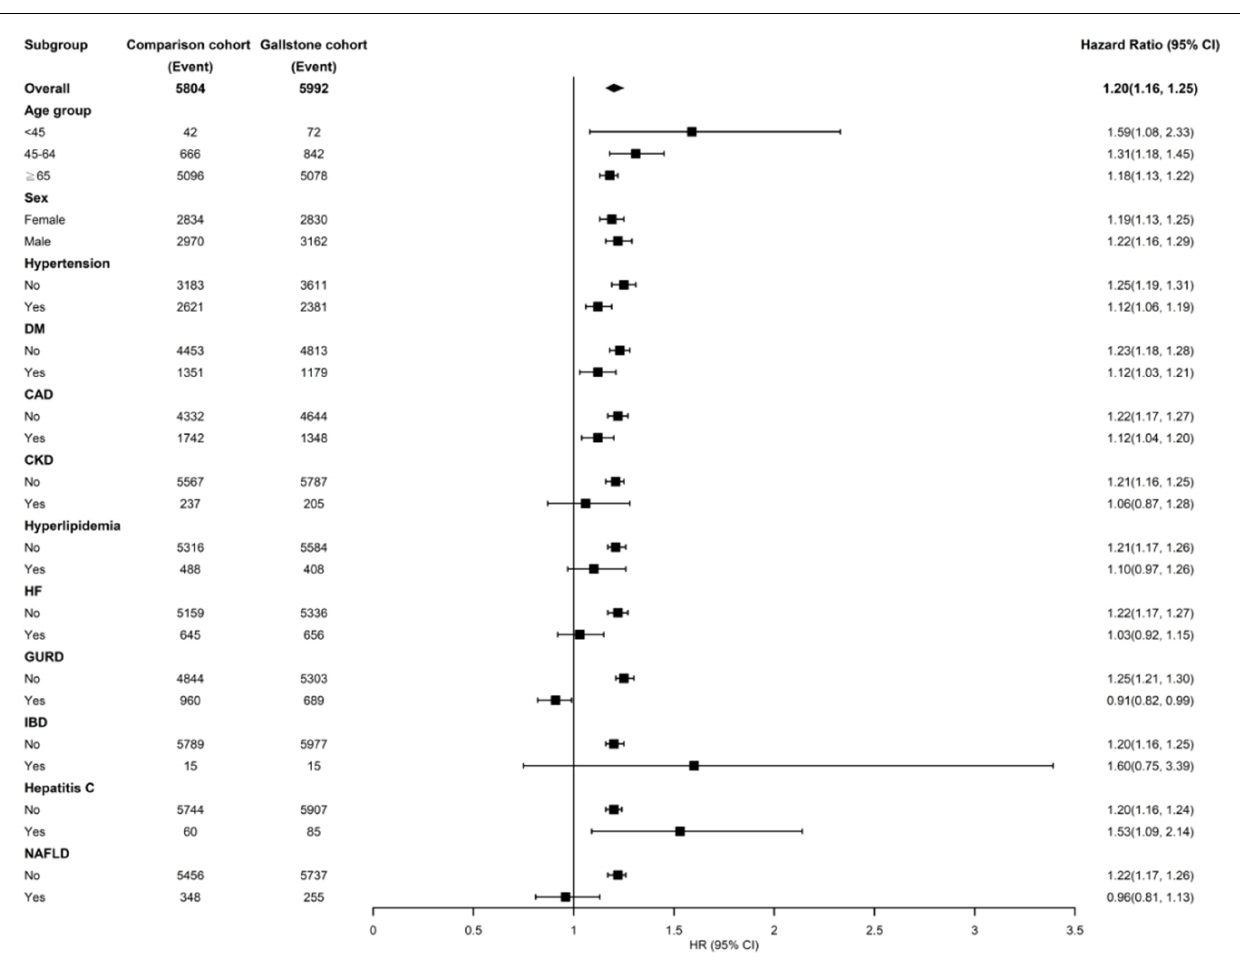
FIGURE 3 | Incidence and hazard ratios of atrial fibrillation stratified by age, sex, and comorbidities in the patients of gallstone disease. DM, diabetes mellitus; CAD, coronary artery disease; CKD, chronic kidney disease; HF, heart failure; GURD, gastroesophageal reflux disease; IBS, inflammatory bowel; NAFLD, nonalcoholic fatty liver